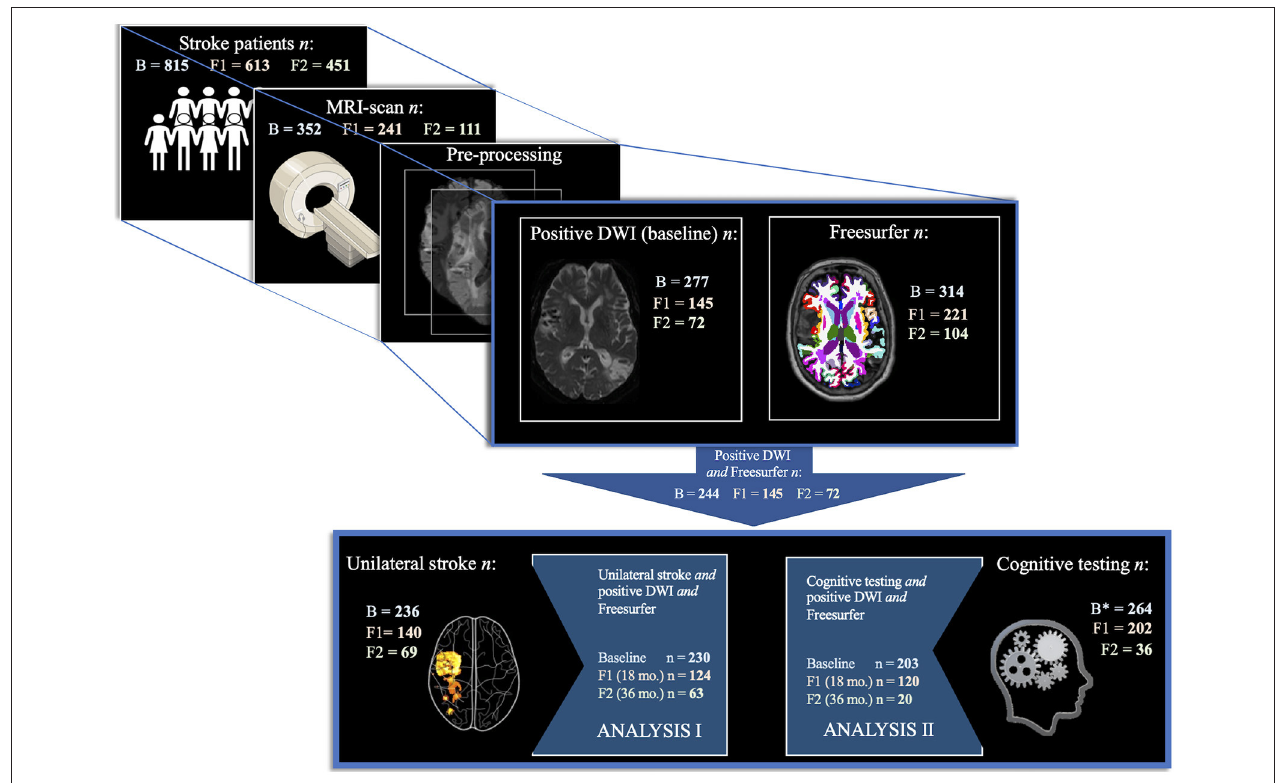
FIGURE 1 | Study population selection. Study population selection by analysis per timepoint. The figure depicts the inclusion process from 815 Nor-COAST participants at baseline, to 352 included in the MRI sub-study, whereupon 277 of these also had the stroke lesion visible on DWI, and 314 had successful Freesurfer anatomical segmentation, resulting in a final study sample of 244 at baseline. Out of these, 230 had a unilateral stroke and was used in analysis I. Out of the final study sample, 203 had cognitive testing at 3 months and was used in analysis II. B, Baseline. B * , Baseline (3 months). F1, Follow-up 1 (18 months). F2, Follow-up 2 (36 months).